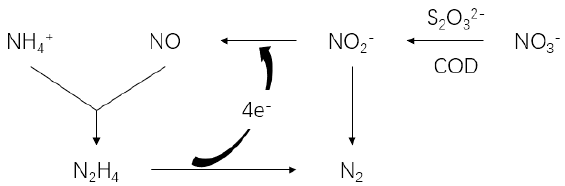
Figure 1. Operational diagram of the anammox, sulfur-based autotrophic denitrification, and heterotrophic denitrification (A/SAD/HD) coupling system.